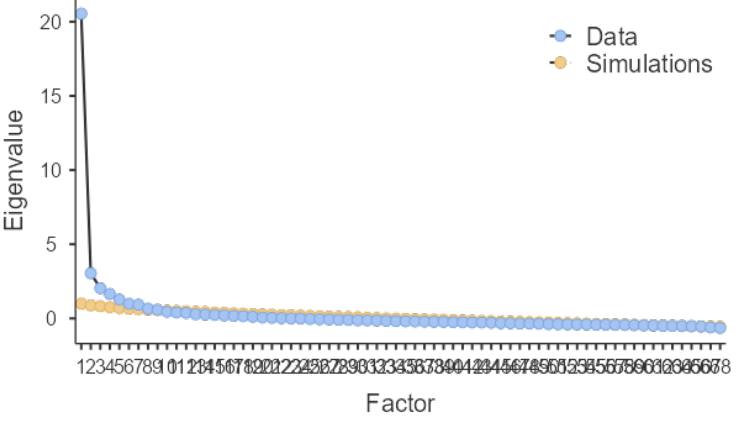
Figure 2. Scree plot. Additional fit indices yielded an RMSEA of 0.052 and a TLI of 0.816 for the entire 68-item BCPS, indicating an acceptable general model